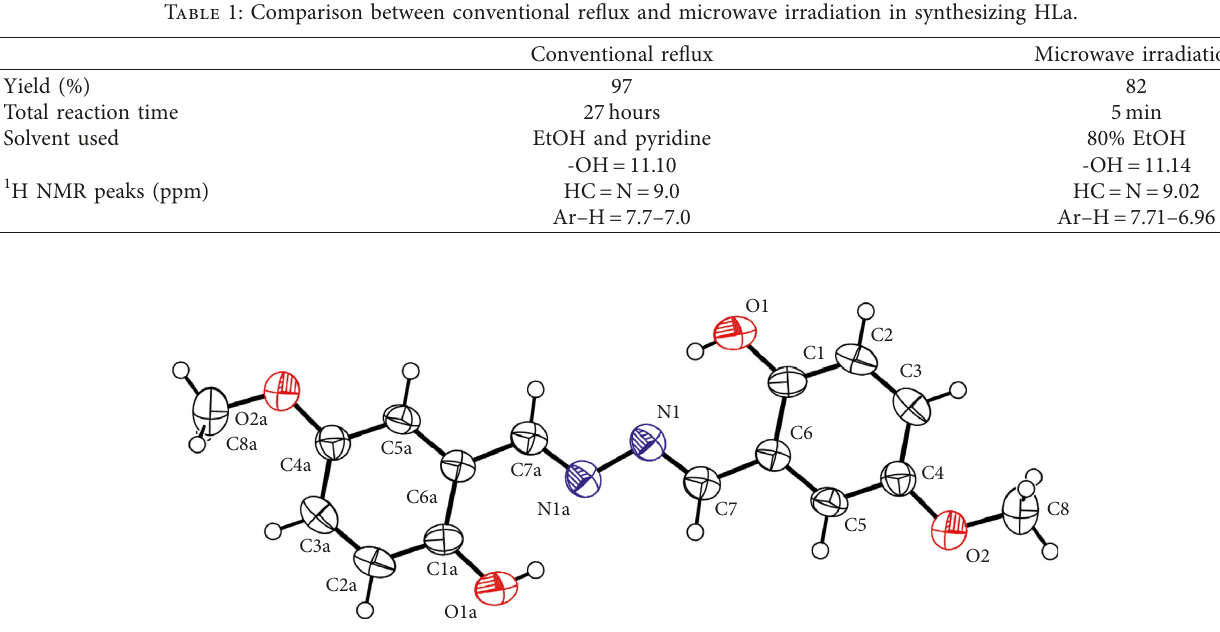
Figure 5: ORTEP view of ligand HLb. Thermal ellipsoids are shown at 50% ellipsoid probability. Table 2: Crystal data of